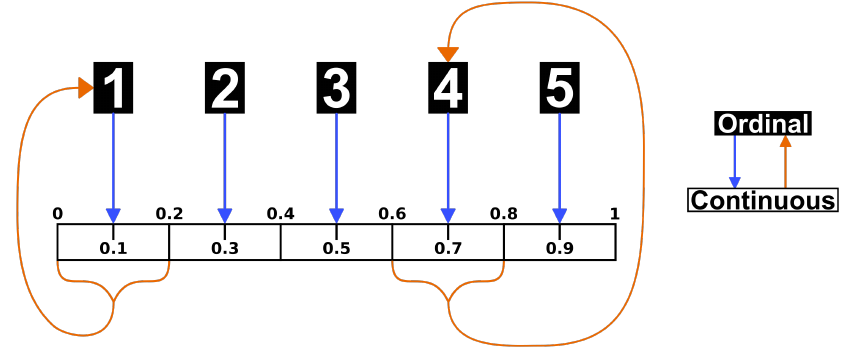
Figure 1. Transformation procedure for a 5-point ordinal